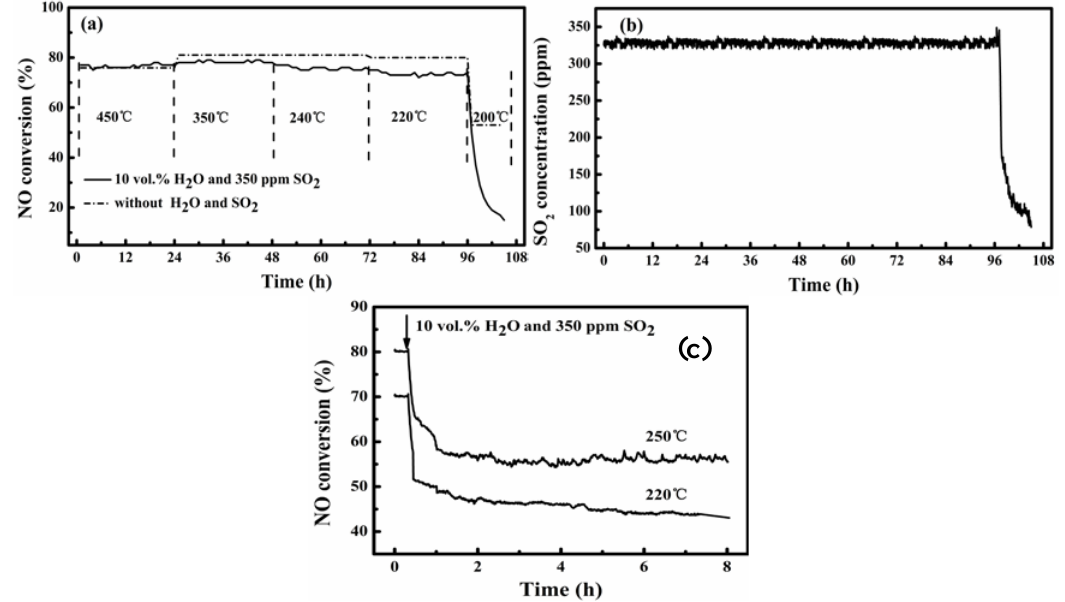
Figure 5. Stability of catalysts A and B for SCR of NO at 200–450 °C in flue gas with SO 2 and water vapor: ( a ) NO conversion over catalyst B in 108-h test at varied temperatures; ( b ) SO 2 concentration at reactor exit corresponding to (a); ( c ) NO conversion over catalyst A at 220 °C and 250 °C (see gas conditions in the Experimental section).